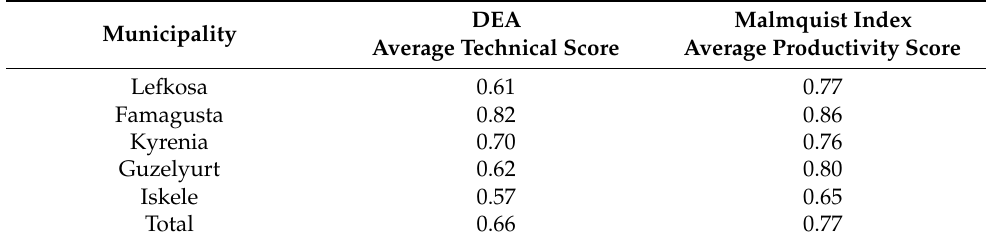
Table 9. Average results for DEA and Malmquist Index.